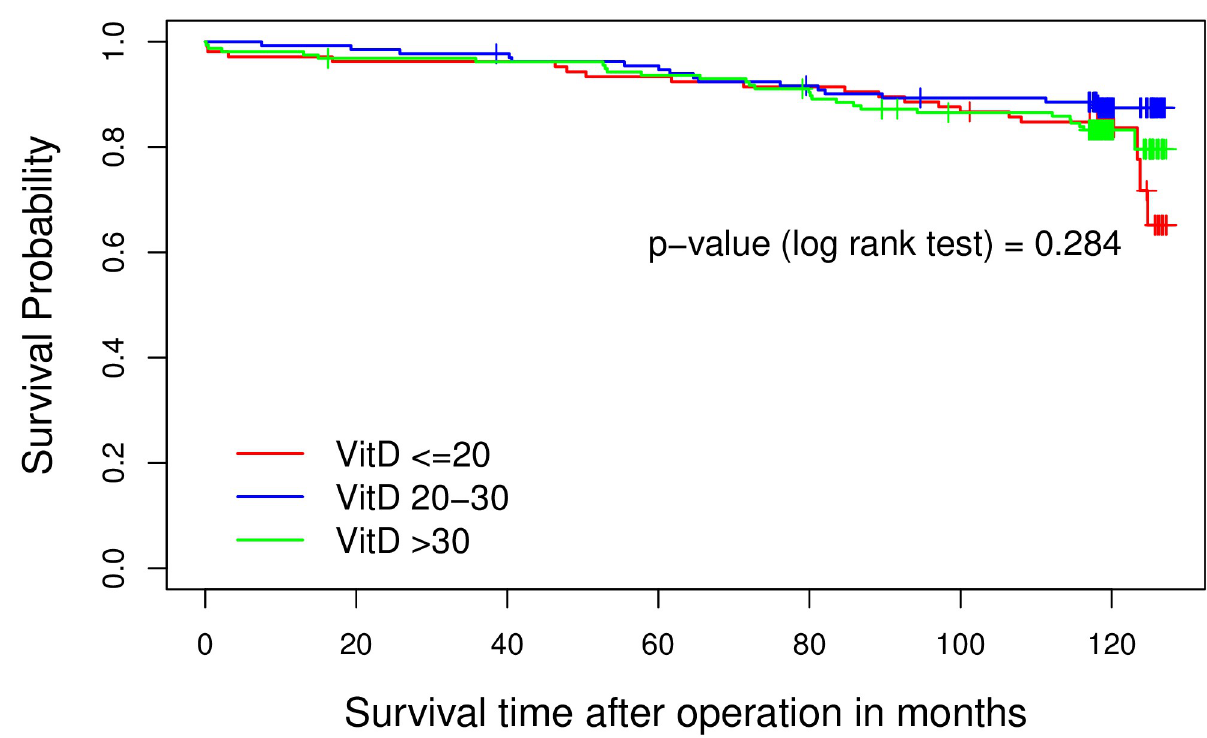
Fig 2. The relationship between 25-hydroxy vitamin D level and survival times in patients who underwent coronary artery bypass graft surgery.